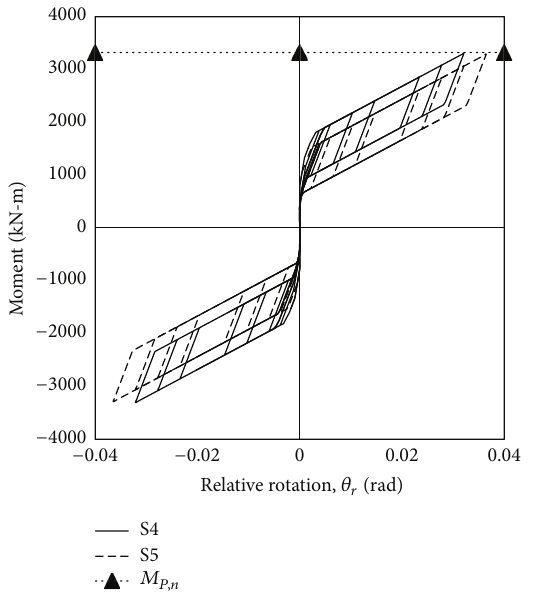
Figure 10: Moment-relative rotation response specimens S4 and S5.